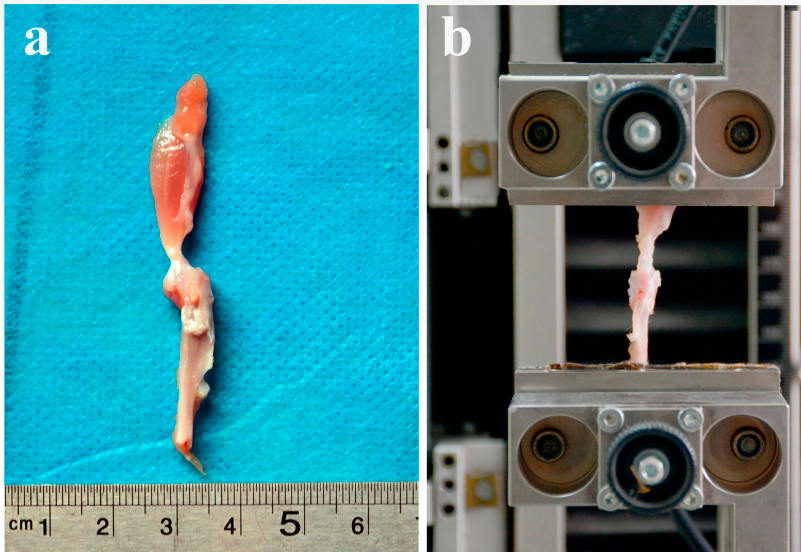
Figure 8. A sketch map of the biomechanical tests. The specimen containing the supraspinatus